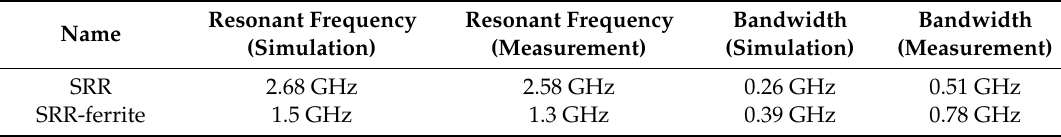
Figure 7. Measurement results of the SRR slab and SRR slab covered by a 0.3 mm thick ferrite film. The resonant frequency of the SRR slab only was around 2.58 GHz. The resonant frequency of the ferrite covered SRR was 1.5 GHz. Table 2. Comparison of the scattering parameters (S parameters). The resonant frequencies of SRR and SRR-ferrite are listed. The measured resonant frequency was lower than the simulation results.